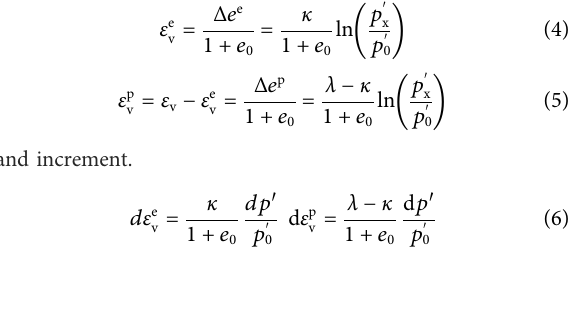
FIGURE 7 e − ln p ′ relations of isotropic compression and